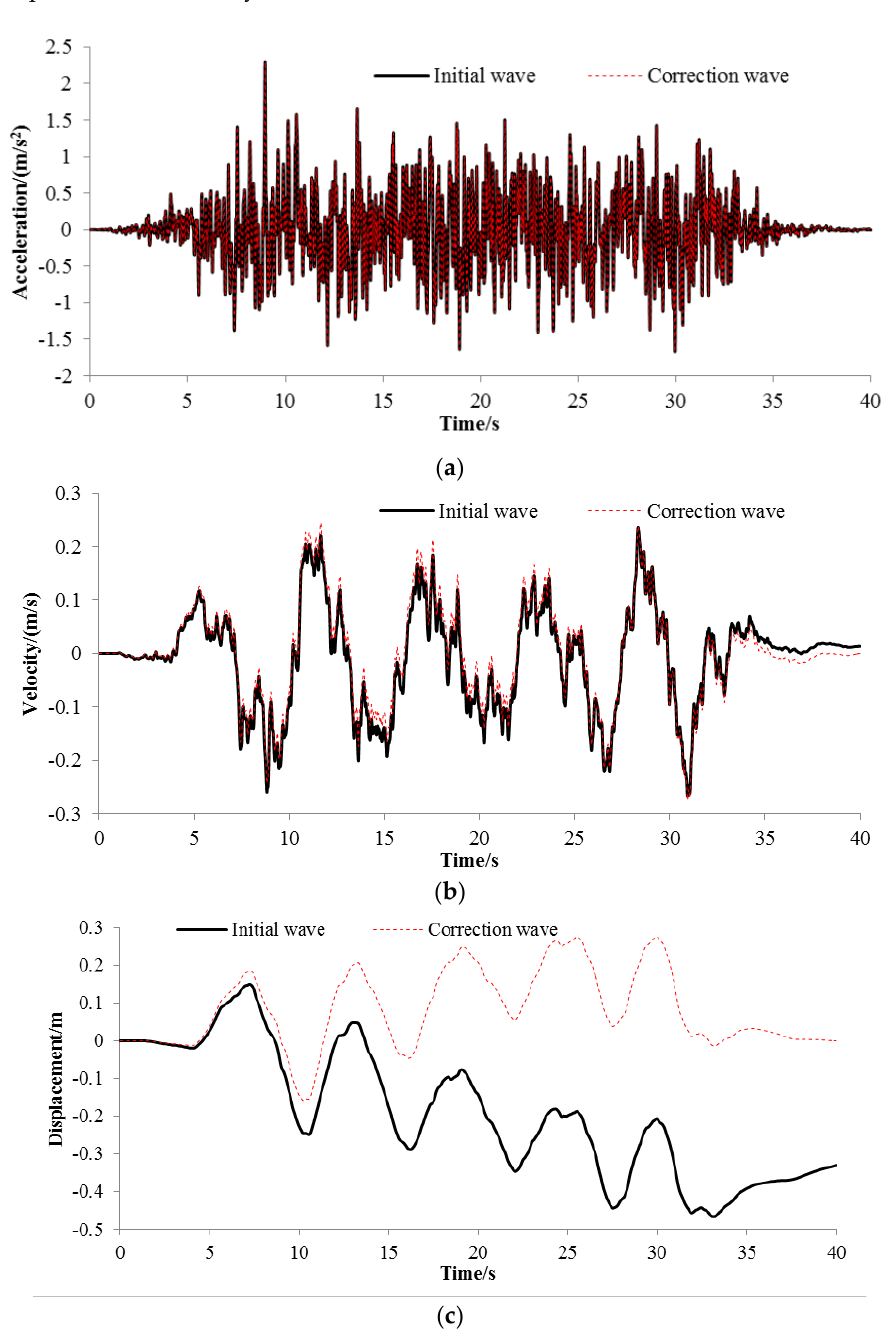
Figure 3. Initial and corrected seismic wave: ( a ) acceleration; ( b ) velocity; ( c ) displacement.